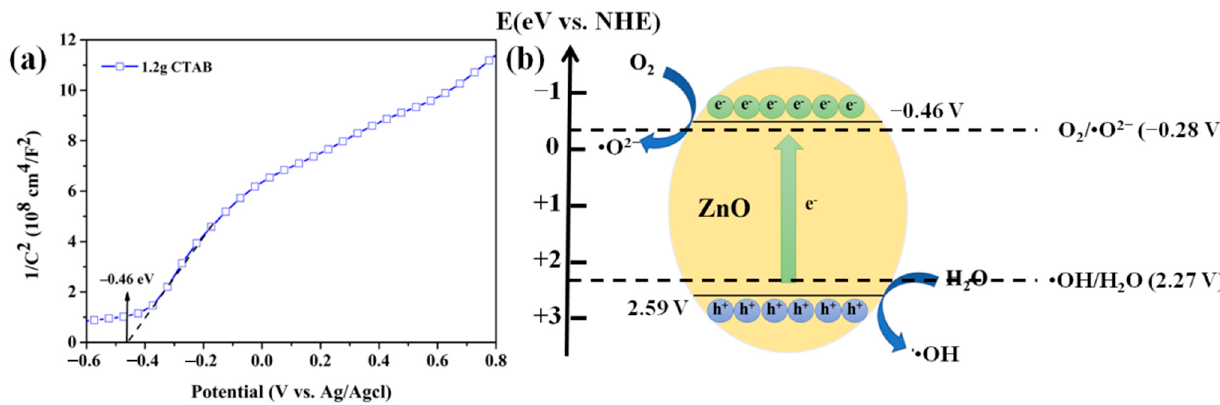
Figure 10. ( a ) The Mott-Schottky plots and ( b ) Photocatalytic degradation mechanism of ZnO nano-rod arrays.